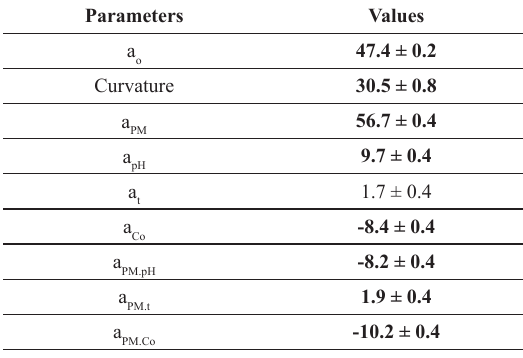
Table 5. Estimated parameters (effect) of the experimental variables for glyphosate adsorption.